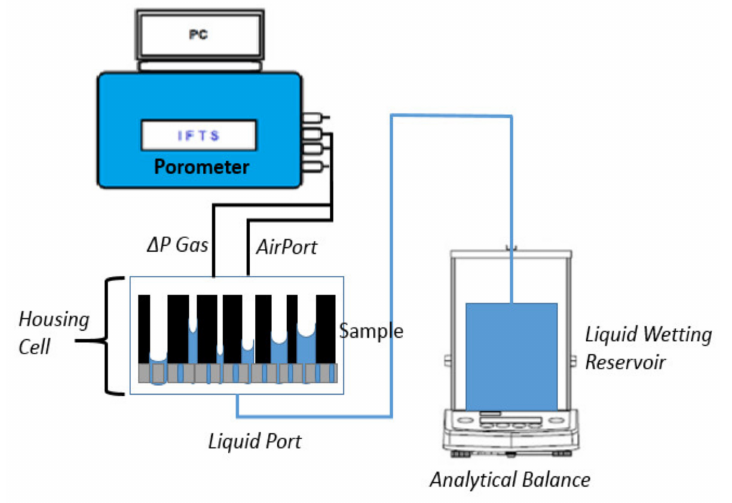
Figure 5. Schematic diagram of liquid extrusion porometer system